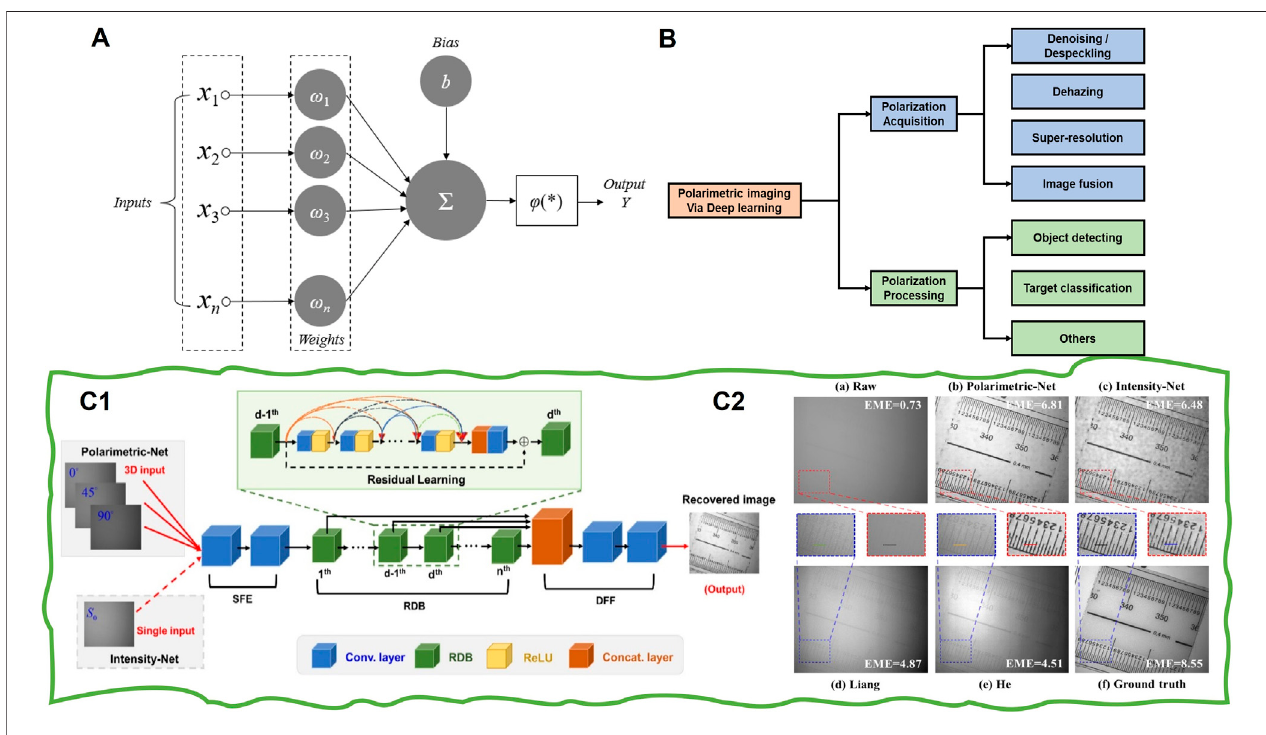
FIGURE 13 | (A) Schematic diagram of neural network structure. (B) Classi fi cation of polarimetric imaging via DL. (C1) The architecture of polarimetric dense network (PDN) and (C2) recovered image (reprint from Elsevier: Optics and Lasers in Engineering [50], copyright